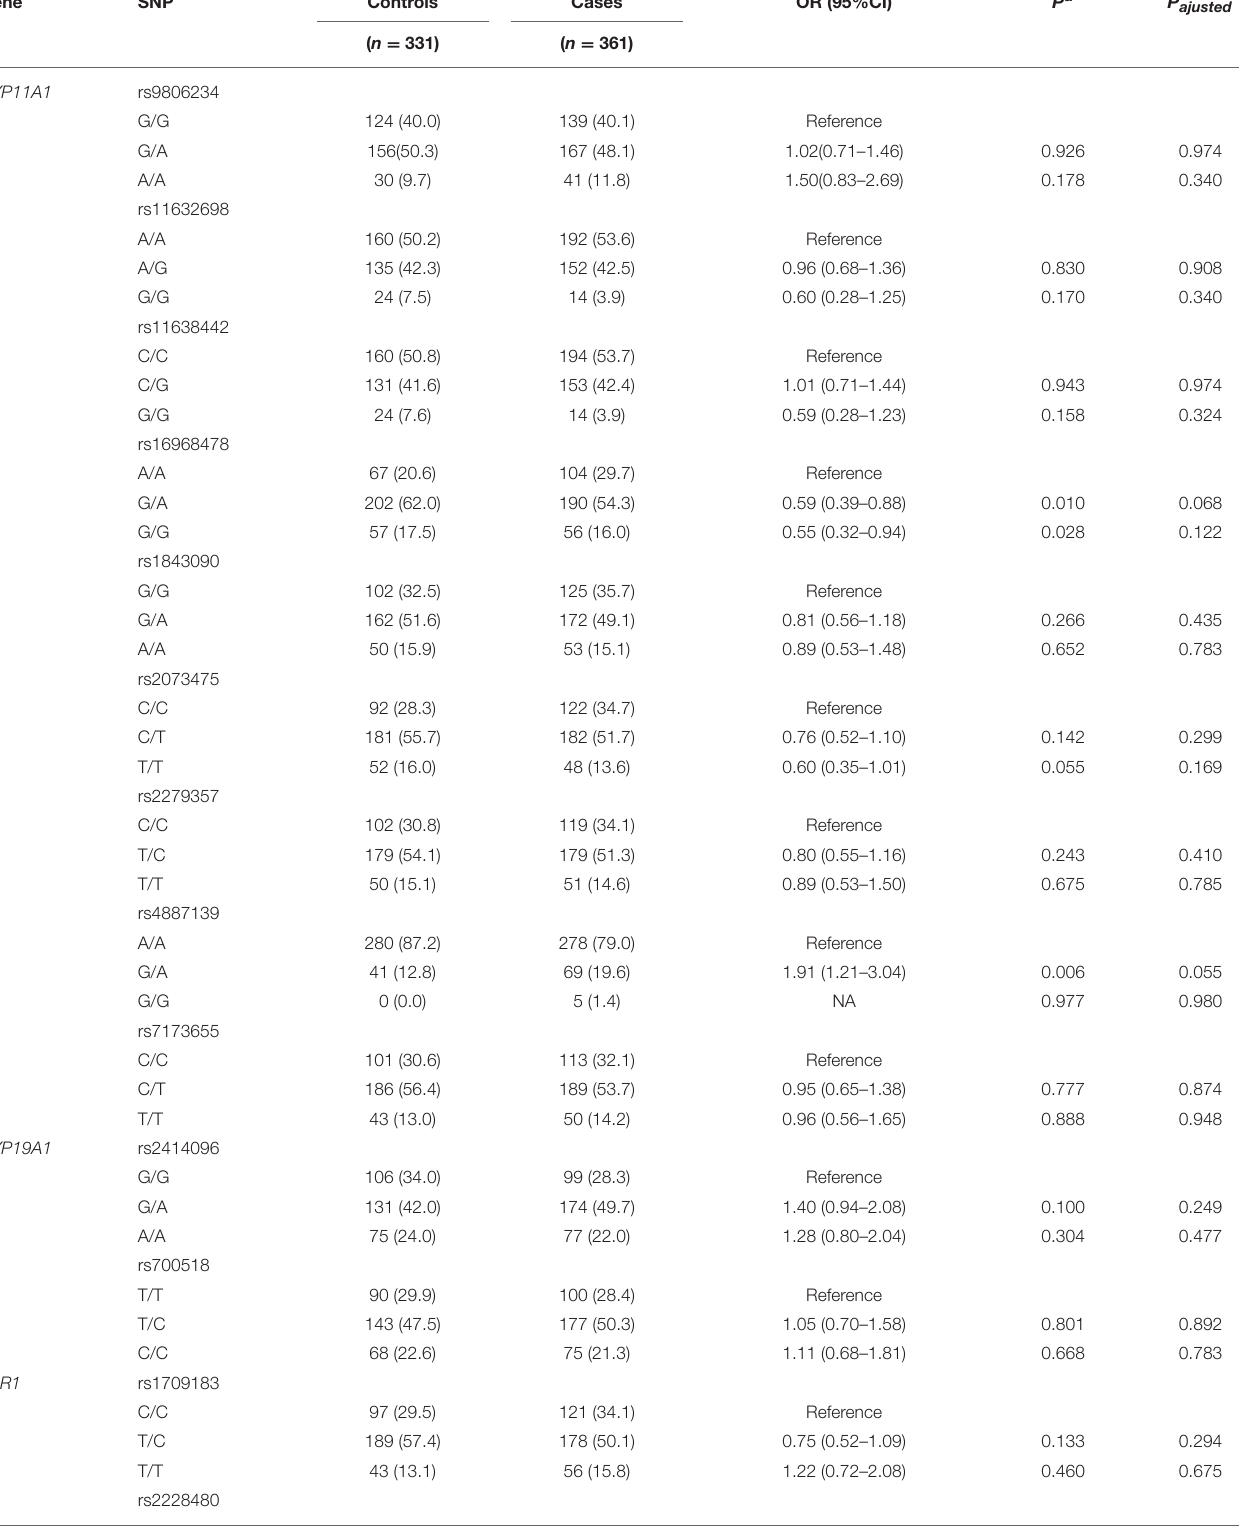
TABLE 4 | Genotype frequencies of selected polymorphisms analyzed in PCOS patients and